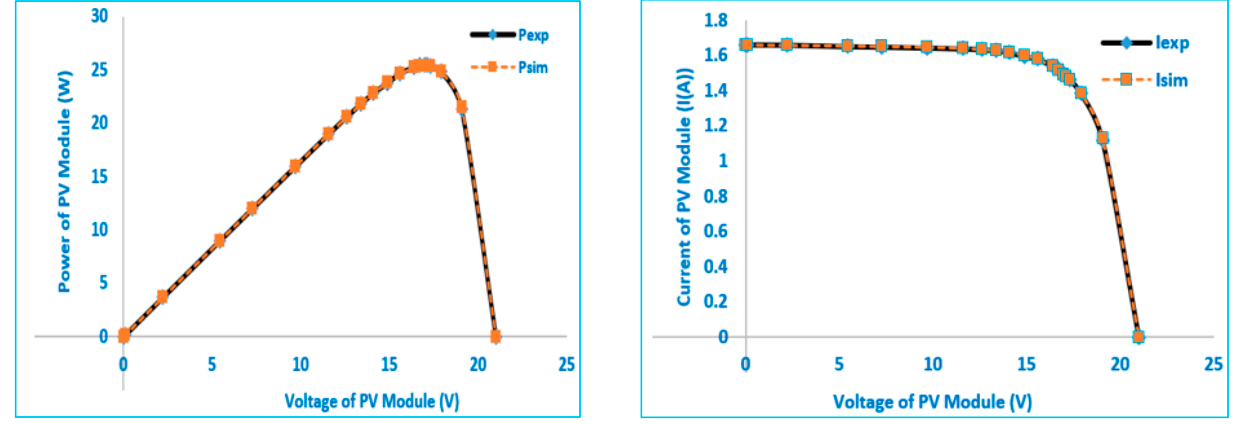
Figure 9. I–V and P–V characteristics of the proposed HPO for the double-diode STM6_40/36 PV module. Table 5. Simulated and experimental current and power and the absolute errors established using the proposed HPO technique for DDM STM6-40/36 PV module.